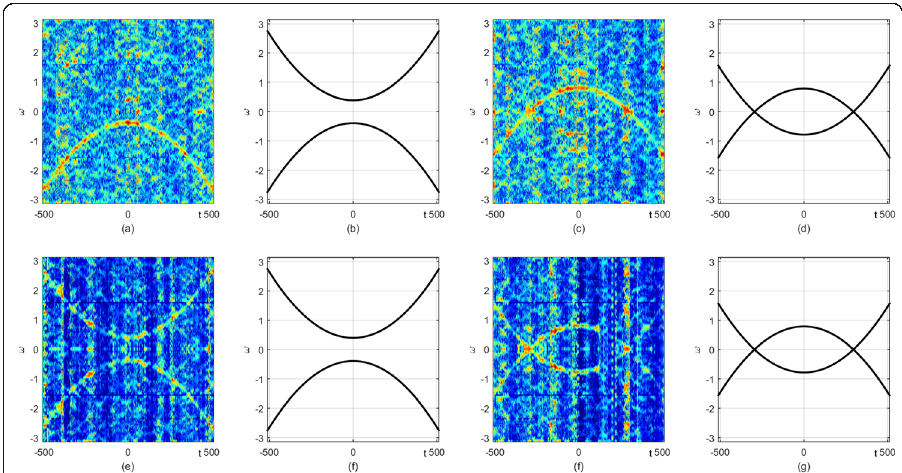
Fig. 11 Two-component cubic phase signal, STFTs (window with 160 samples) and IF estimates (thick line — estimates, dashed lines — true IFs) for K / N =25% of available samples: a , b Components with different amplitudes and separable in the TF plane; c , d Components with different amplitudes with IFs intersecting in the TF plane; e , f Components with same amplitudes and separable in the TF plane; g , h Components with same amplitudes with IFs intersecting in the TF